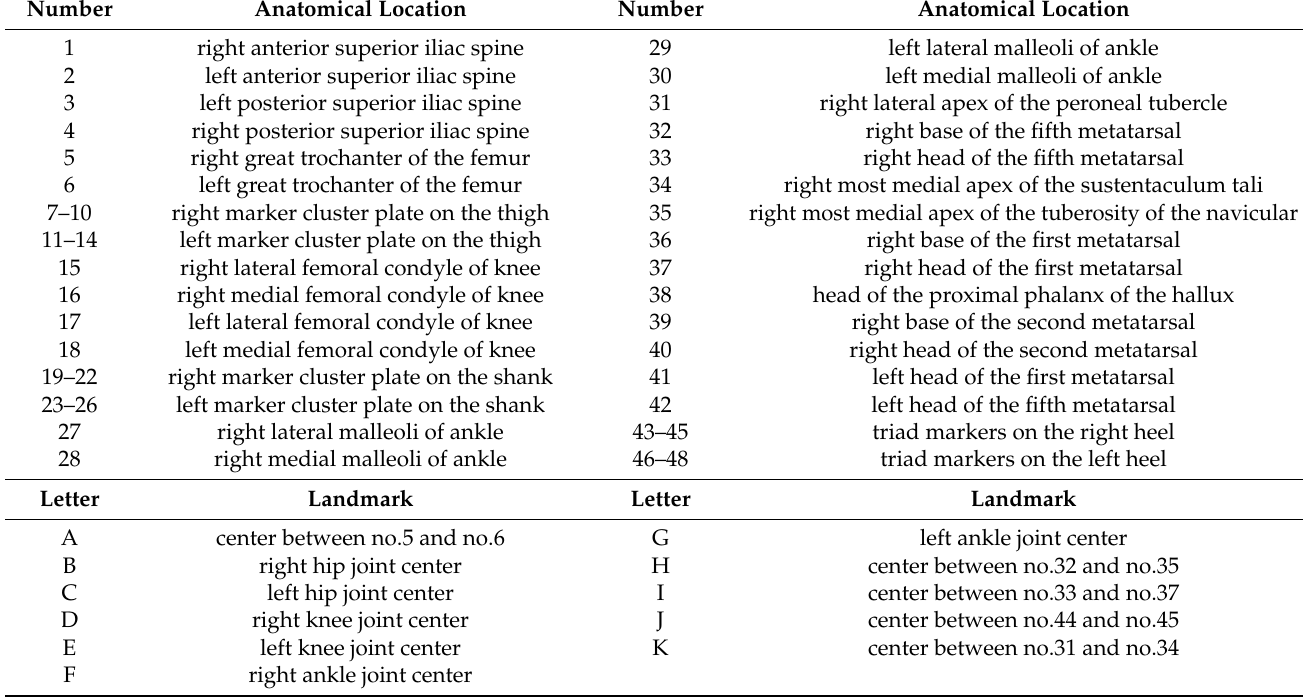
Figure 1. Marker placement model of lower extremities. Table 1. The legend for Figures 1 and